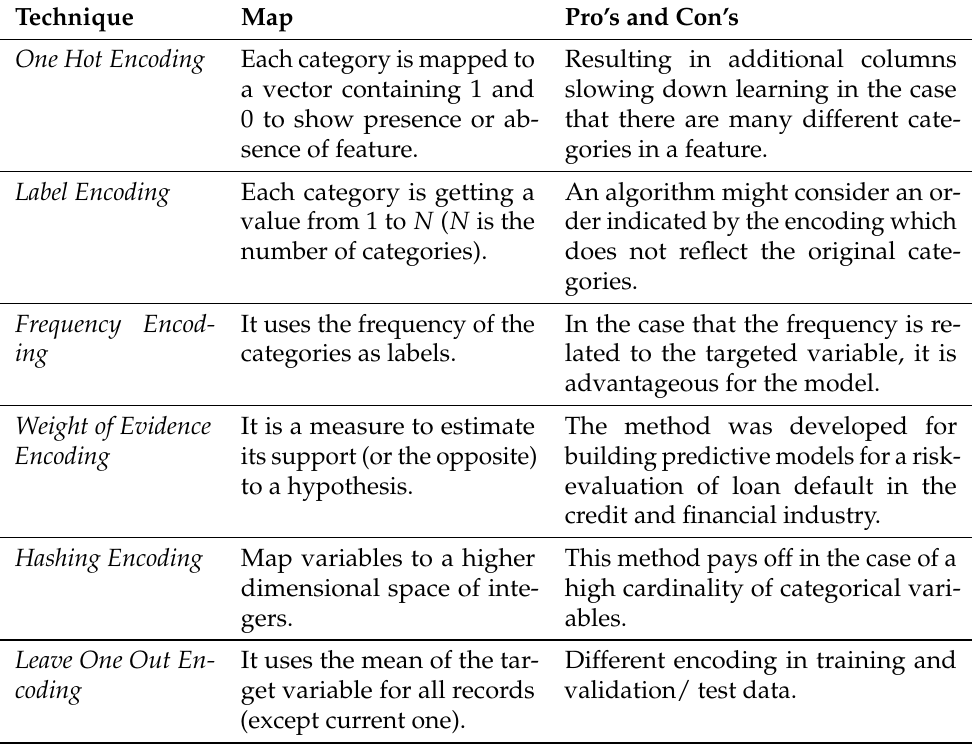
Table 1. Categorical variable encoding